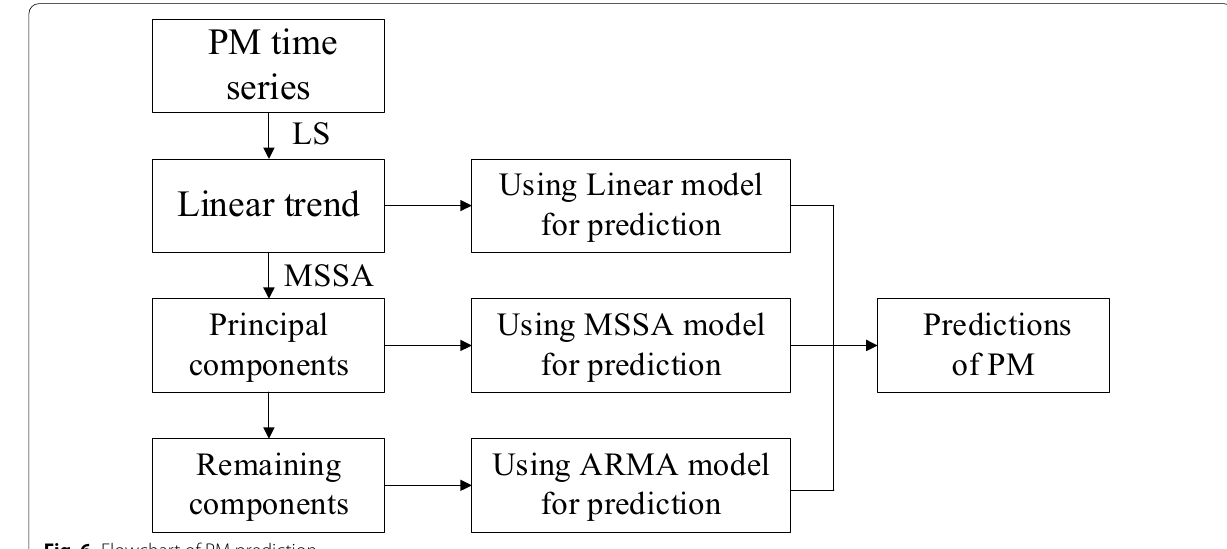
Fig. 6 Flowchart of PM